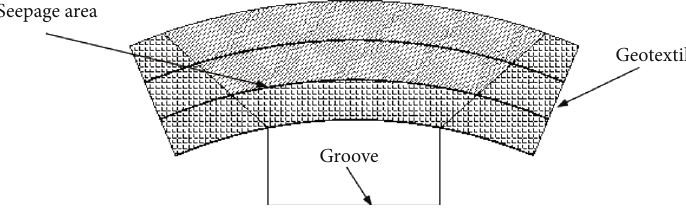
Figure 14: Schematic diagram of the increase of water area.